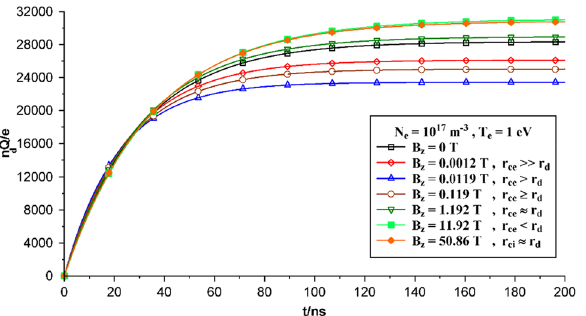
Figure 3. Time evolution of the dust particle charges with the plasma density n 0e = 10 17 m −3 , magnetic field B z = 0, 0.0012, 0.0119, 0.119, 1.192, 11.92, 50.86 T, and initial electron temperature T 0e = 1